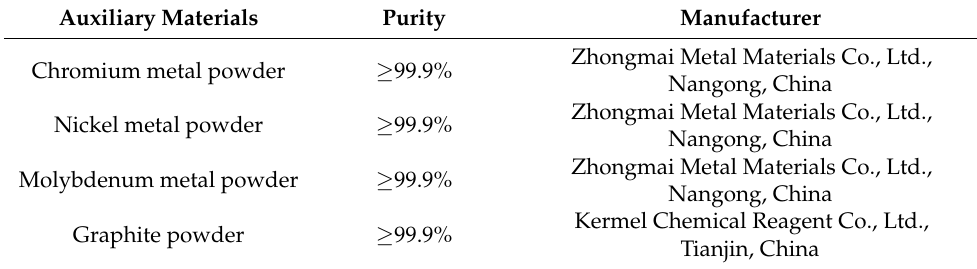
Table 3. Basic information about auxiliary materials.